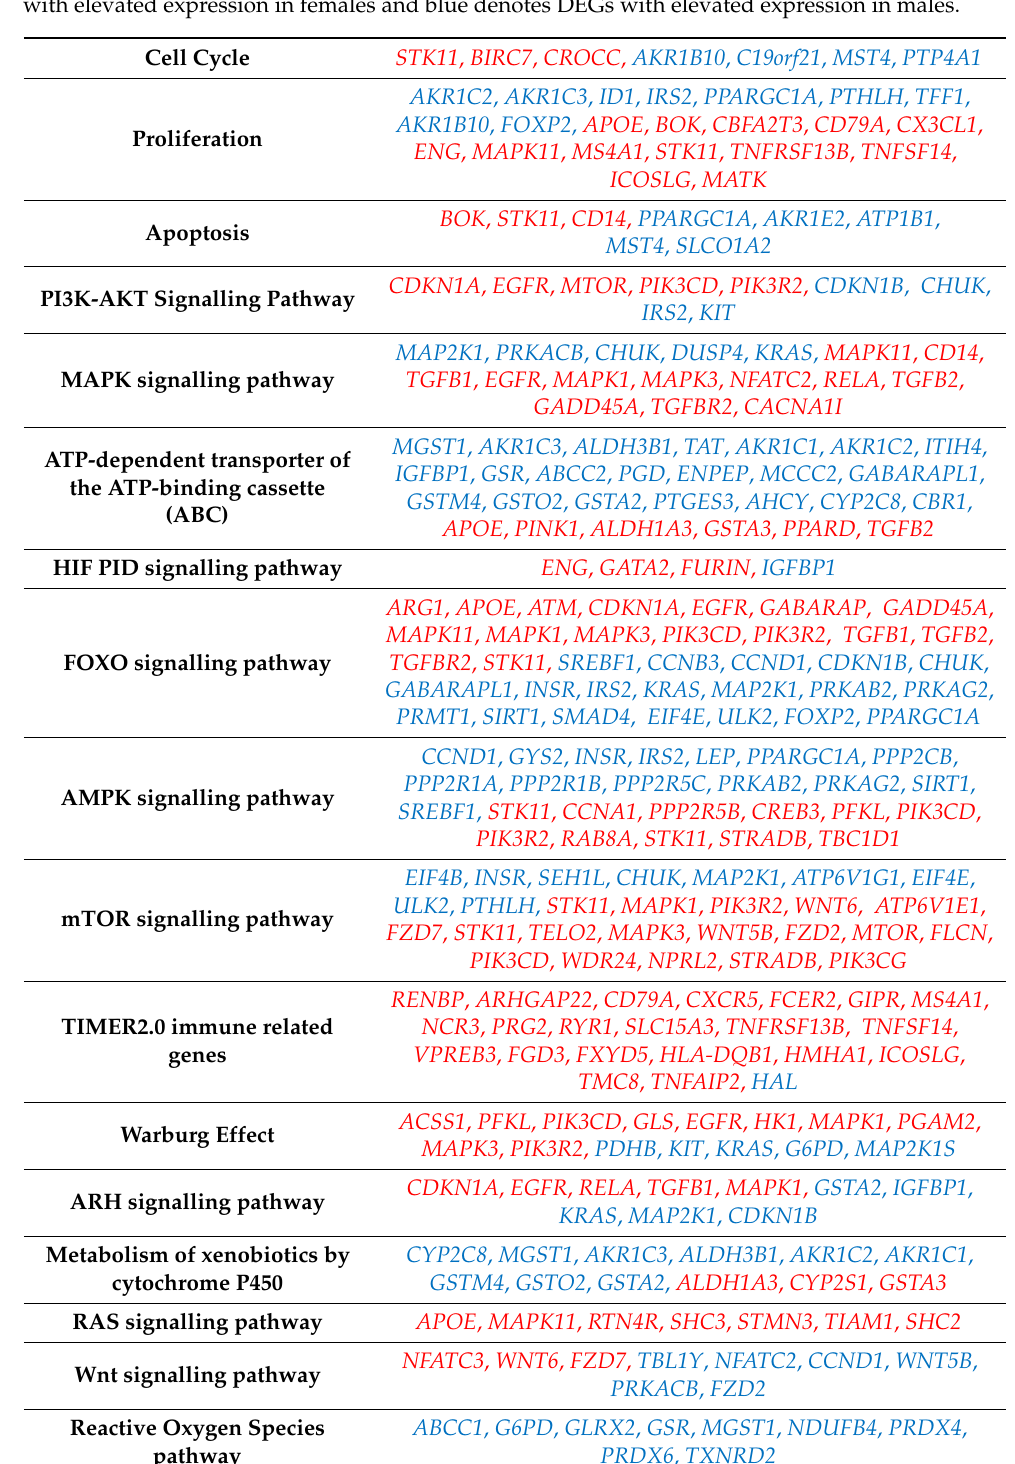
Table 1. Enrichment analysis regarding sex-disparate pathways following DEG identification and confirmation using EdgeR ( p < 0.05). This table details a selection of pathways significantly enriched in our LUAD cohort using ShinyGo enrichment analyser (Supplementary Tables S4 and S5) and following literature search with validation from Human MSigDB gene collection. Red denotes DEGs with elevated expression in females and blue denotes DEGs with elevated expression in